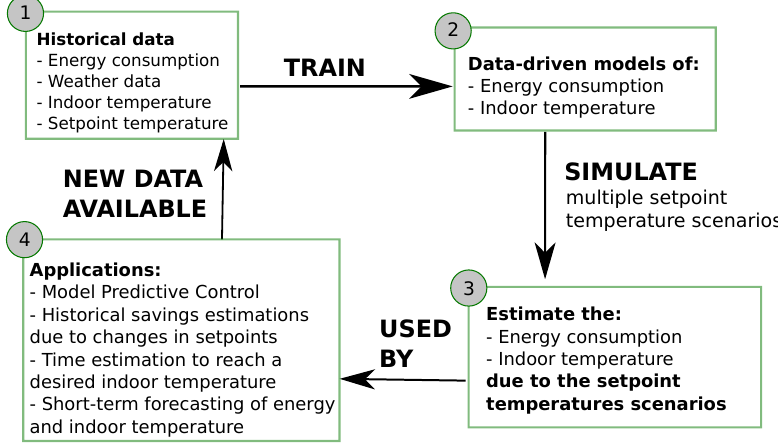
Figure 1. General steps and objectives of the modeling technique